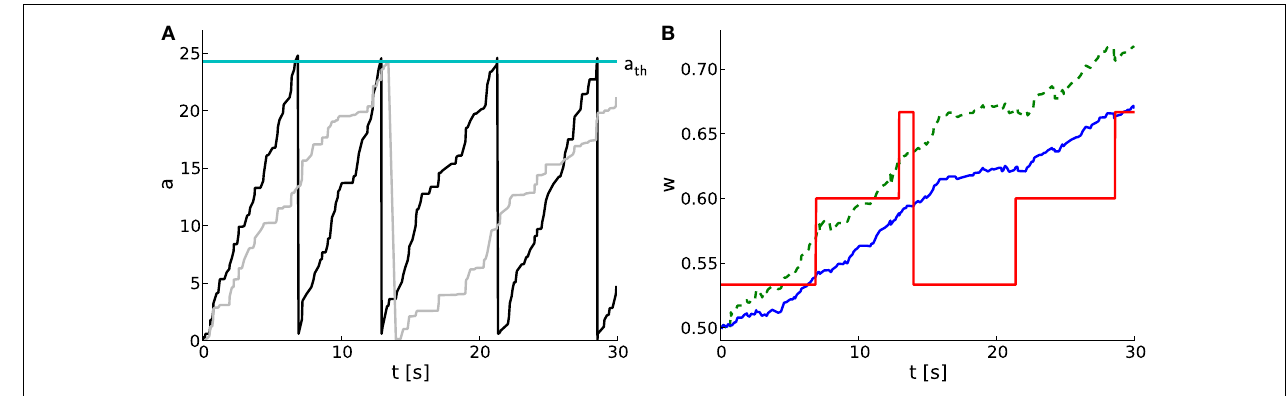
evolution (solid red) for a 4-bit weight resolution and a LUT configured with n = 30.The weight evolution of the reference synapse model with continuous weights, but a reduced symmetric nearest-neighbor spike pairing scheme is depicted in solid blue. It differs from that of a synapse model with continuous weights and an all-to-all spike pairing scheme (dashed green).